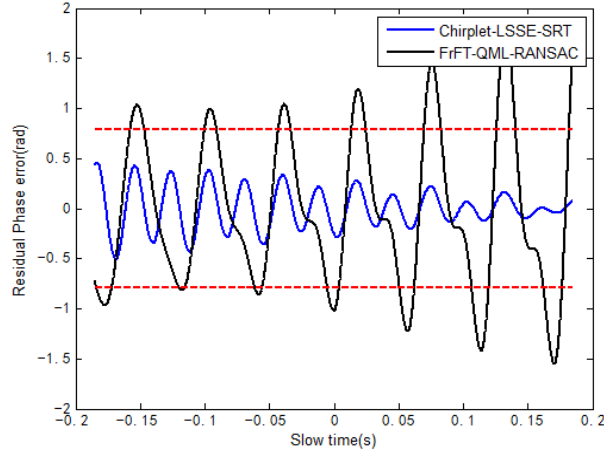
Figure 14. Residual phase errors of the distributed imaging scene.